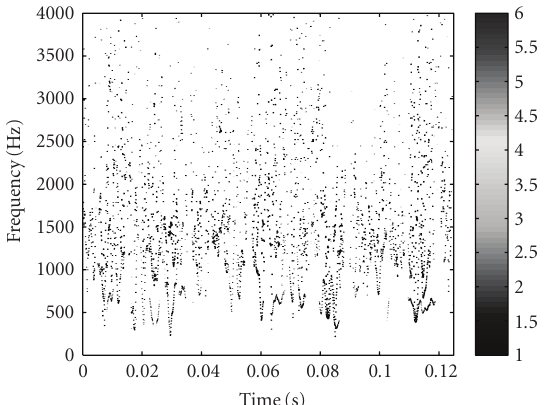
Figure 11: HHT spectrum of vibration signal shown in Figure 8. Figure 12: THT spectrum of vibration signal shown in Figure 8.